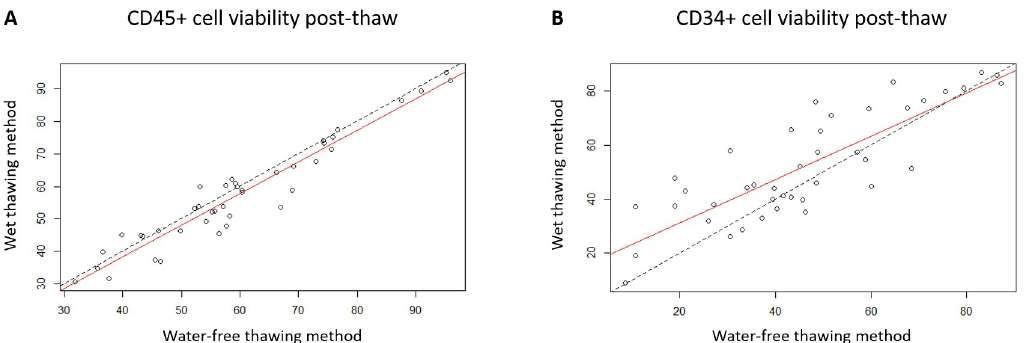
Fig 2. Bland-Altman analysis of the two different thawing methods. Plots of post-thaw viability, comparing wet and water free thawing methods with line of equality for (A) CD45+ and (B) CD34+ post-thaw viabilities, determined through flow analysis.